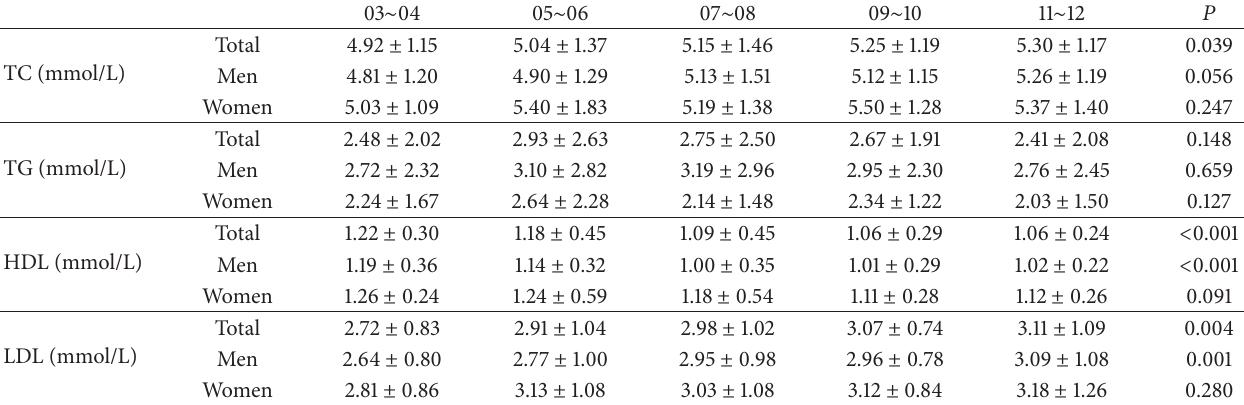
Table 2: Serum lipids and lipoproteins levels in patients with newly diagnosed type 2 diabetes in Chongqing,